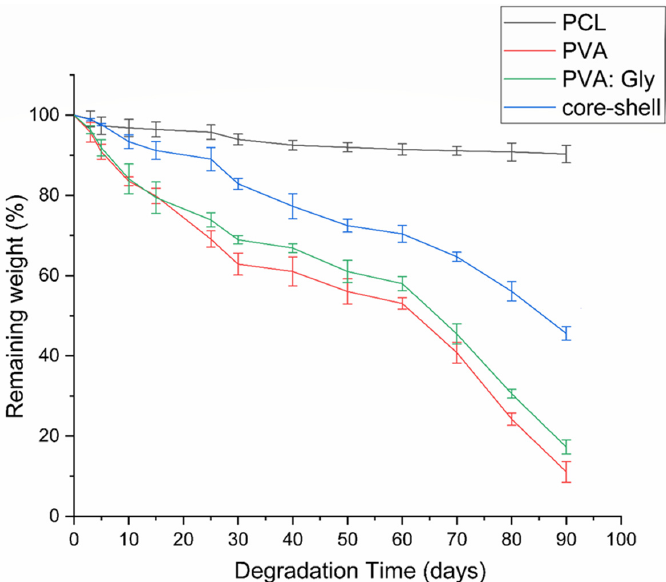
Figure 8. Remaining weight of PCL, PVA, PVA:Gly, and core-shell membranes during 90 days of incubation in PBS. All readings are presented as remaining weight% ± standard deviation.